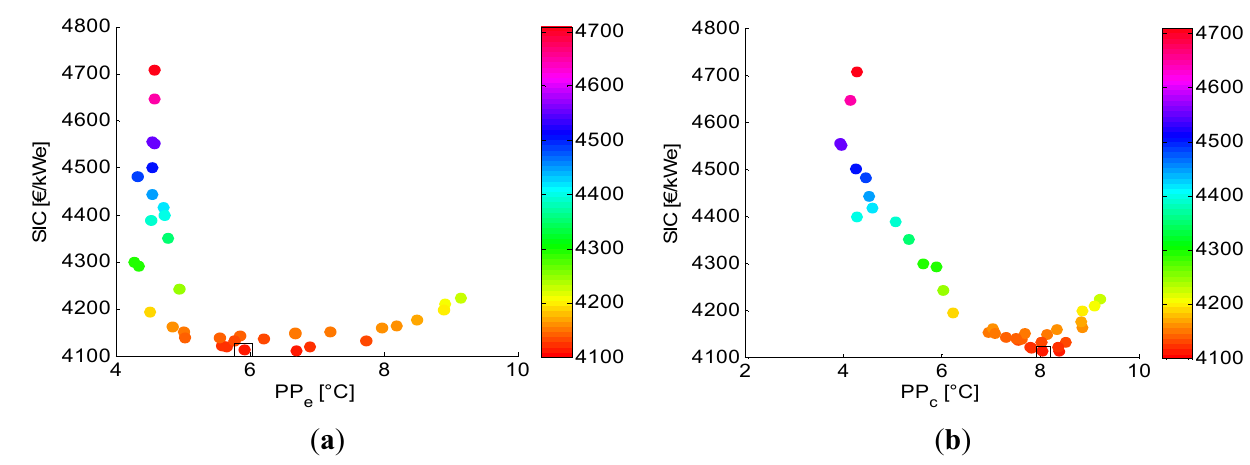
Figure 4. Pareto front SIC vs. net power output ( (cid:1849)(cid:4662) cycle (TCORC).